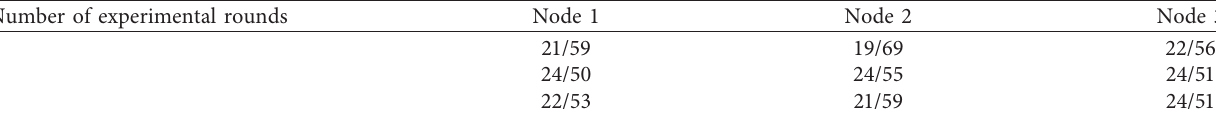
Table 4: The experimental values of the